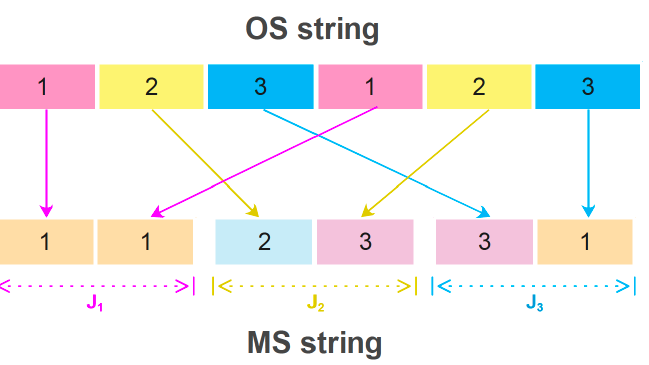
Figure 2. Coding of the solution in the Gantt diagram of Figure 1 in sequences OS and MS